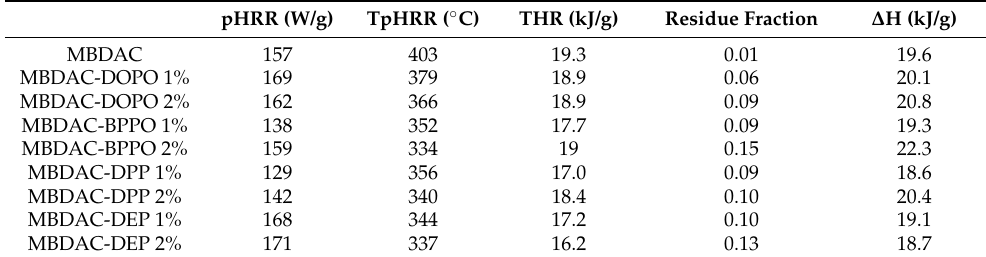
Table 3. Main data from PCFC for all PHUs.